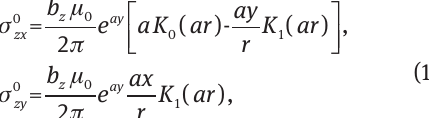
/4, (A) when a = 0.1 for z = c and a = 0, 0.1, and 0.5. 2 1